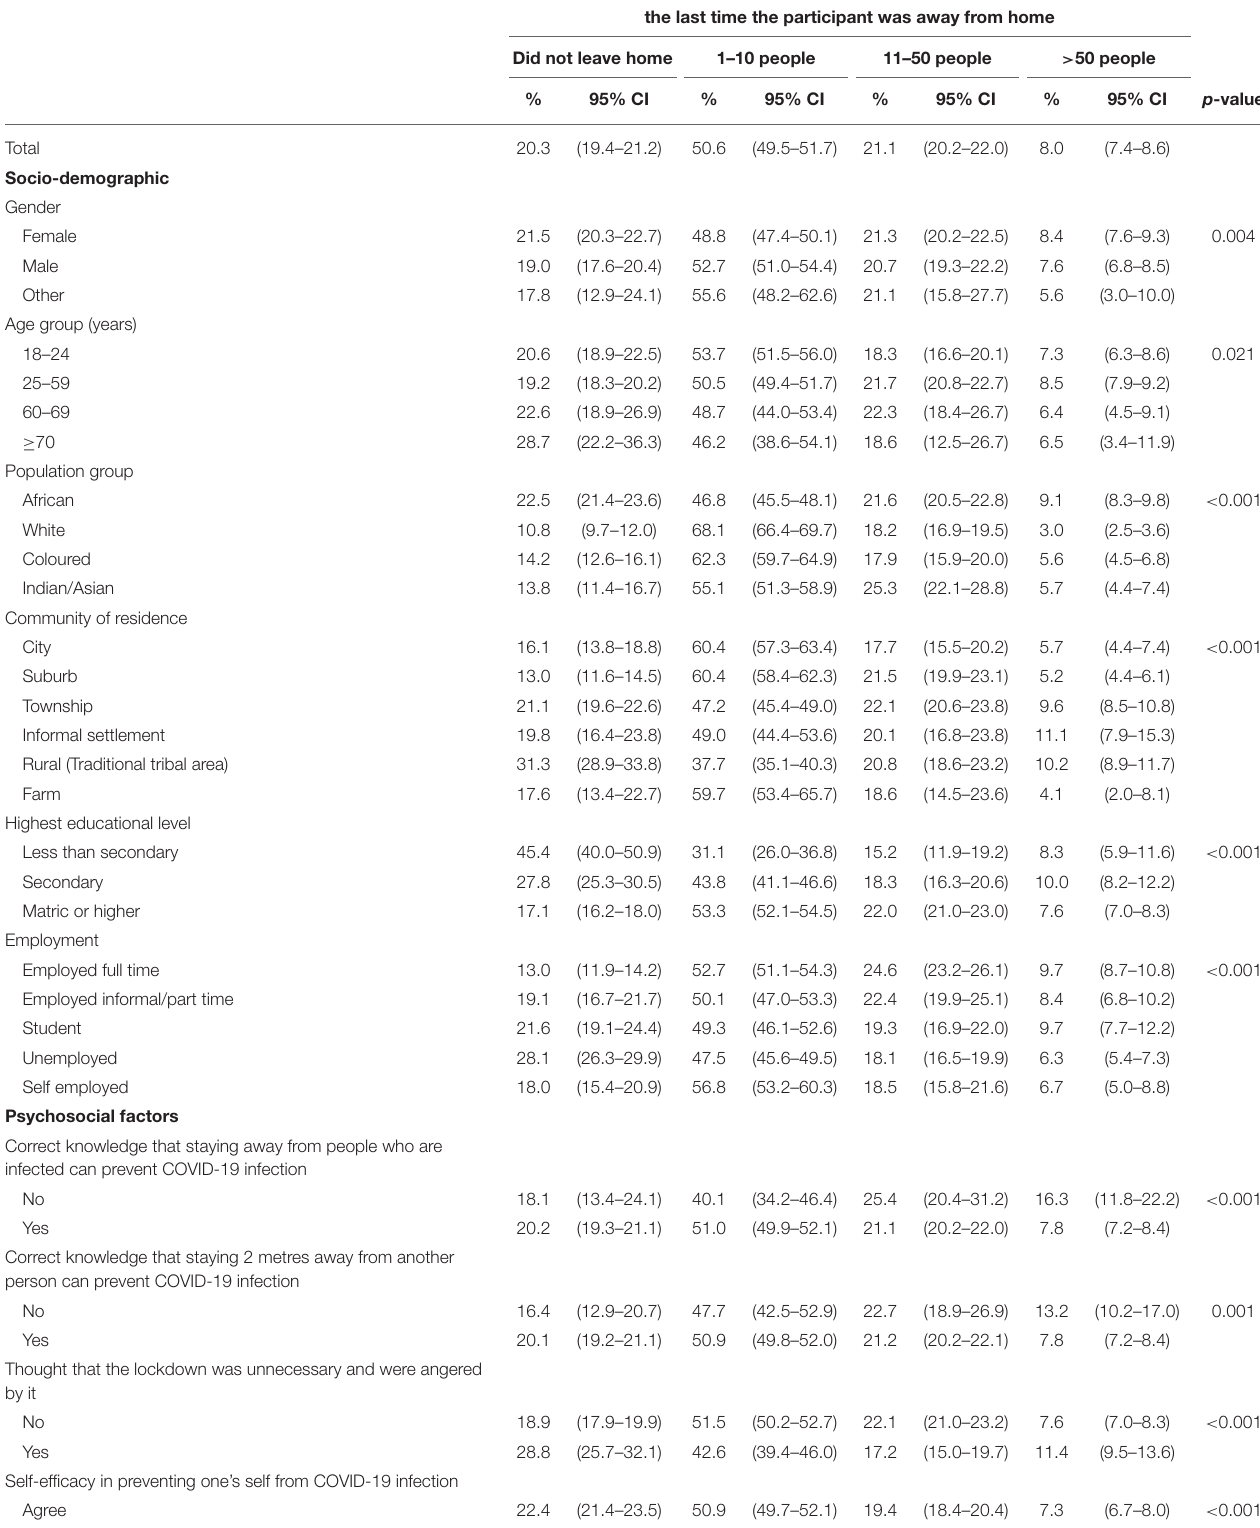
TABLE 2 | The number of close contacts when outside the home by socio-demographic characteristics and behavioural determinants. Number of people in close contact with (within a 2-metre distance) the last time the participant was away from home Did not leave home 1–10